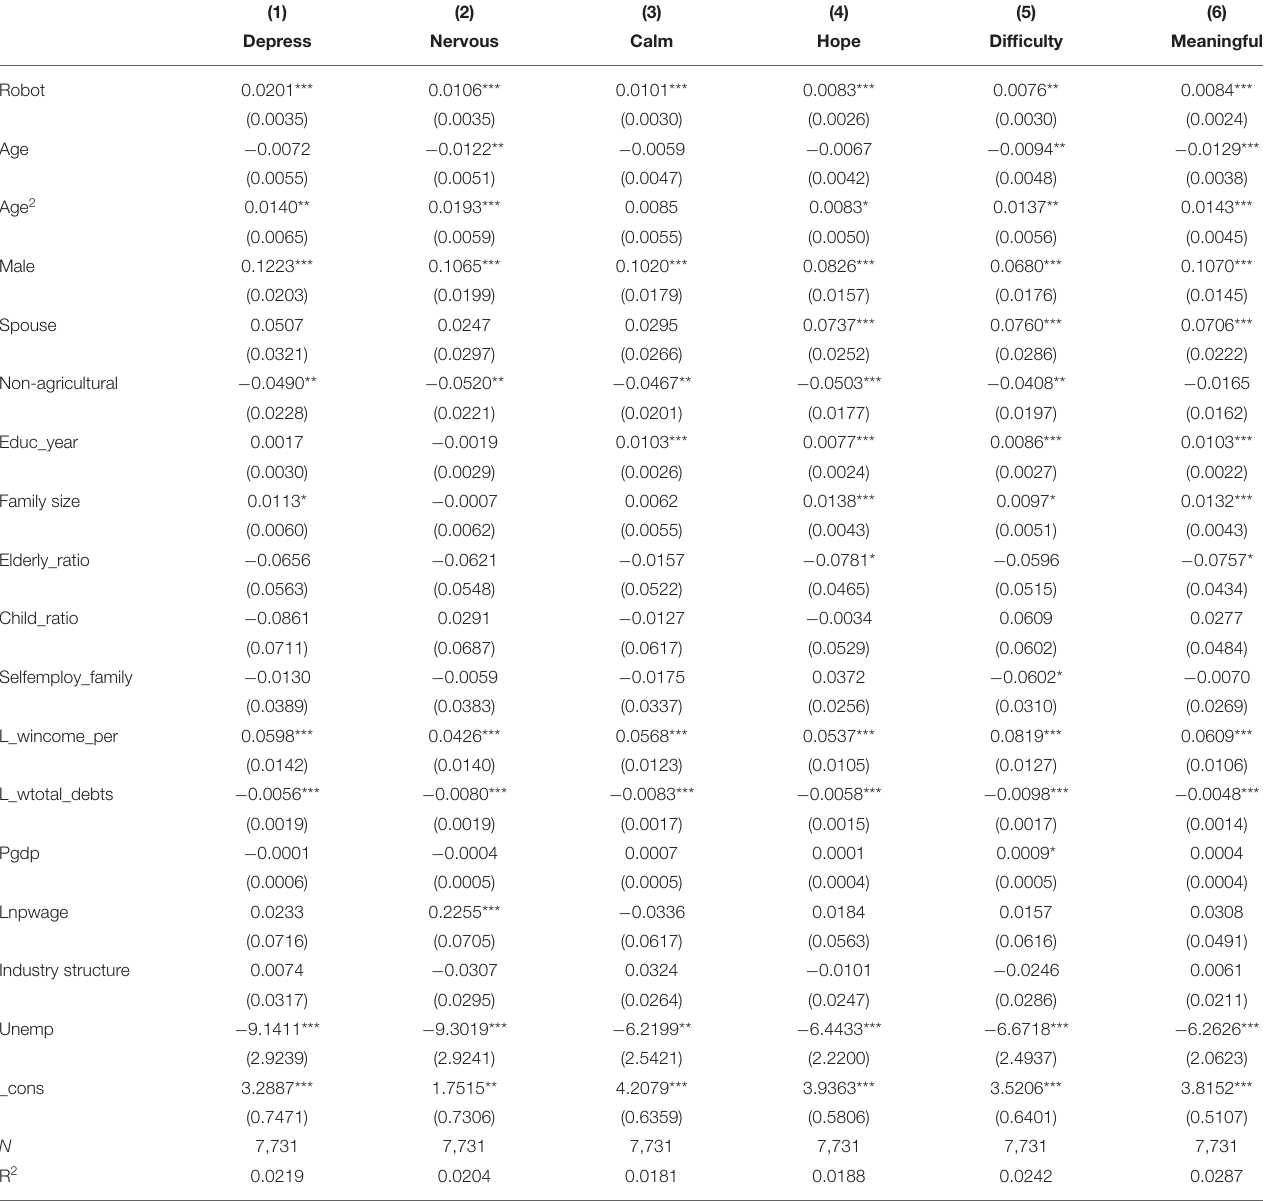
TABLE 2 | Impact of AI transformation on workers’ mental health: baseline